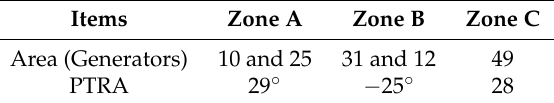
Table 3. Limits of fault events in the three zones.